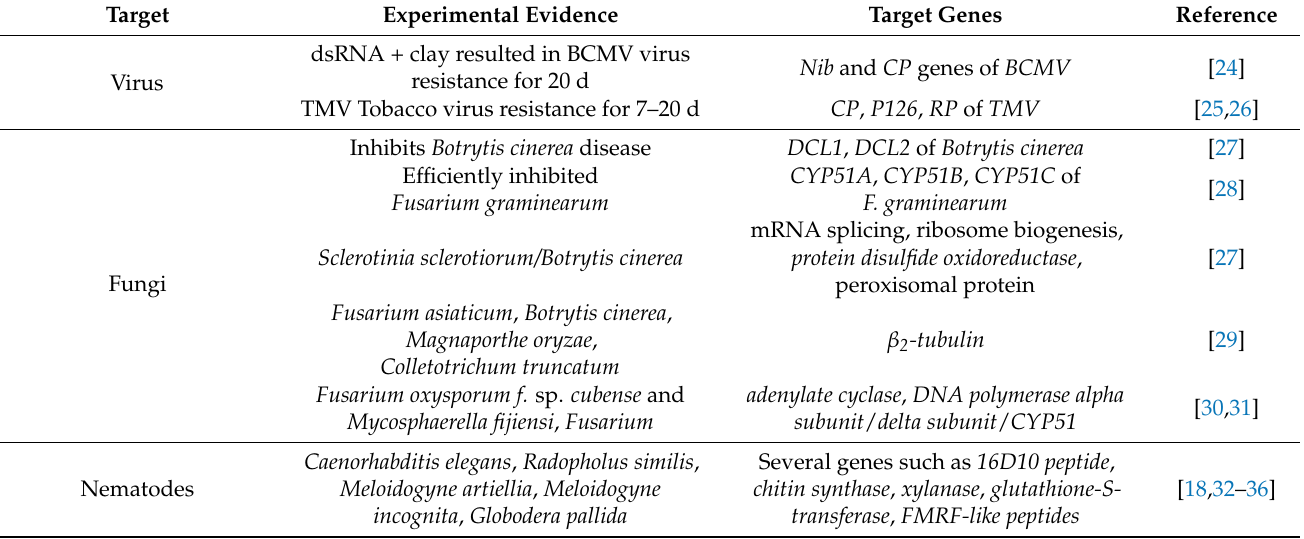
Table 1. Potential targets for spray-induced gene silencing (SIGS) in plants.